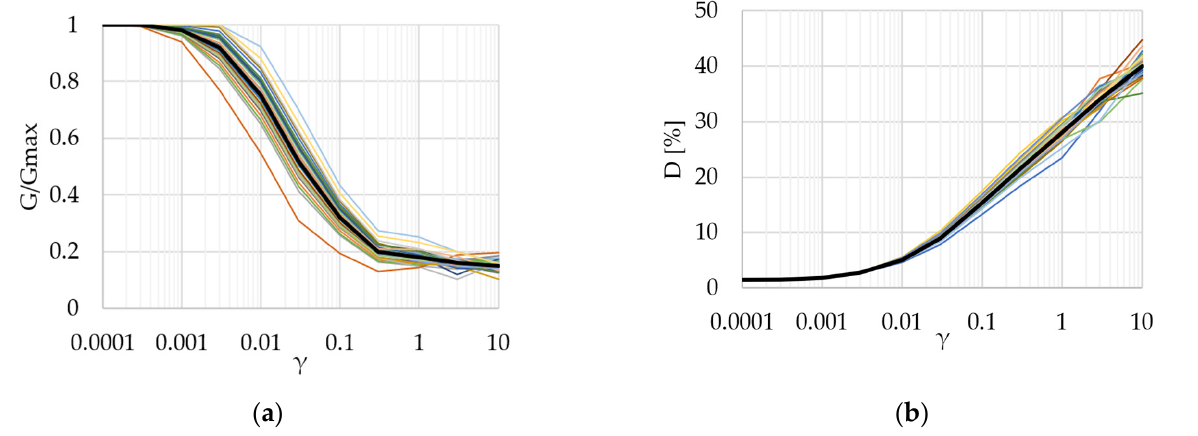
Figure 15. Probabilistic linear-equivalent soil behavior curves: ( a ) G- γ ; ( b ) D- γ .